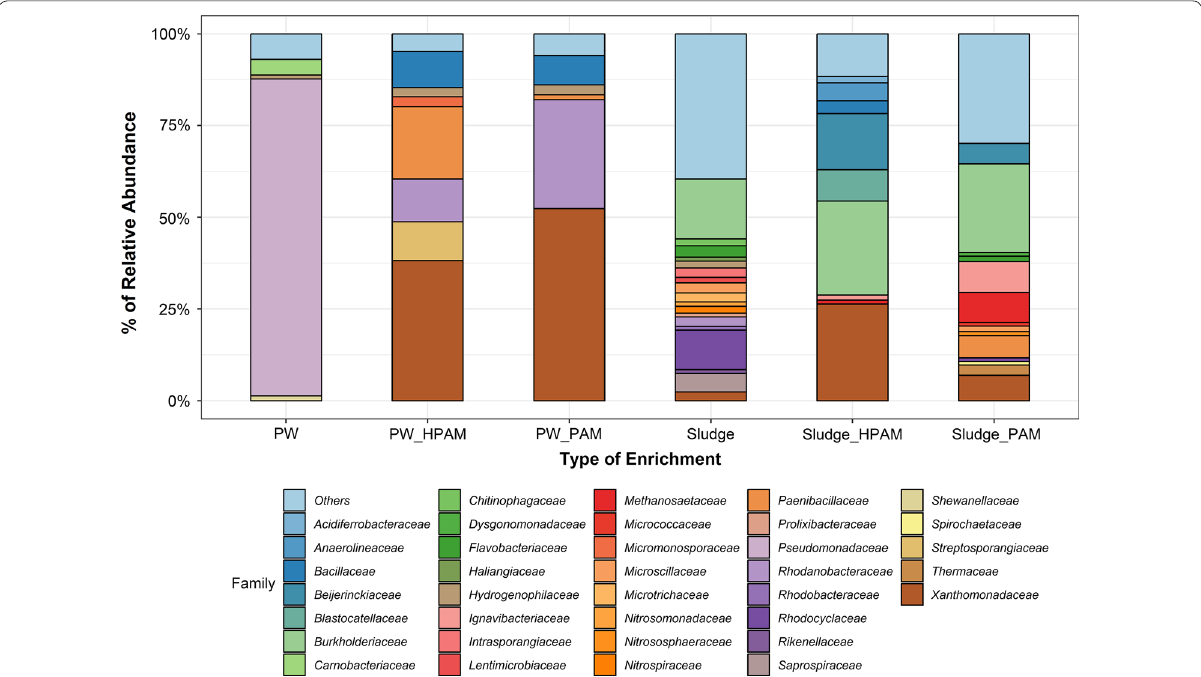
Fig. 5 Microbial community compositions of the original oilfield PW sample (PW), PW enrichments (PW_HPAM, PW_PAM), wastewater sludge sample (Sludge), and sludge enrichments (Sludge_HPAM and Sludge_PAM), based on the relative abundances of taxa identified at the family level (only OTUs > 1% of the total reads are shown). Total number of reads in PW: 128,354, PW_HPAM: 11,1687, PW_PAM: 66,474, Sludge: 52,795, Sludge_ HPAM: 24,656, and Sludge_PAM: 3836. Taxa with relative abundance < 1% or that could not be identified at the family level are grouped together